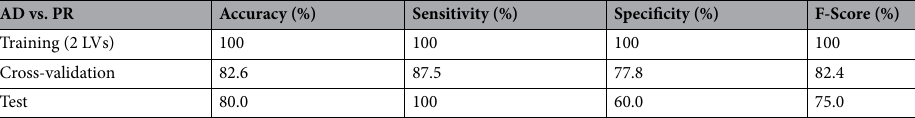
Table 3. Classification parameters for plasma samples in active disease (AD) vs. paired remission (PR).